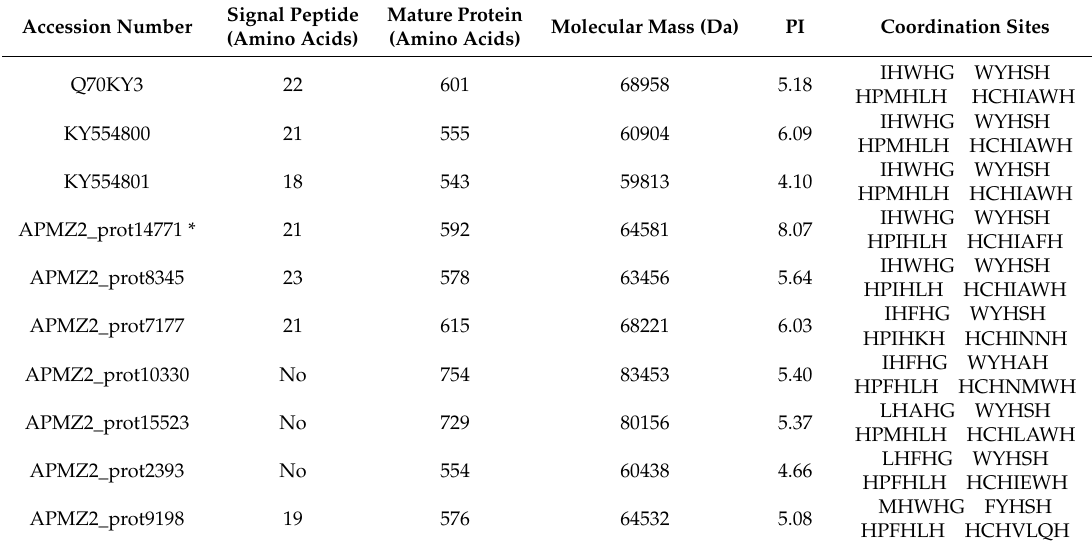
Table 1. Properties of the putative laccases of Stemphylium lucomagnoense and the closest characterised laccases from the terrestrial fungus, Melanocarpus albomyces ( Ma Lac1: Q70KY3), and the marine-derived fungus Pestalotiopsis sp. KF079 ( Ps Lac1: KY554800 and Ps Lac 2: KY554801), including the number of amino acids of the signal peptide and the mature protein, the calculated molecular mass and pI, and the amino acids involved in the enzyme coordination sites for the Type 1, 2 and 3 coppers. APMZ2_prot14771 * encoding Sl Lac2 was deposited in the nucleotide sequence database (GenBank) under the accession code MT470191.